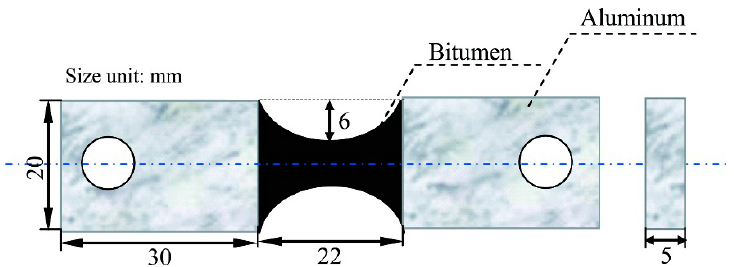
Figure 2. Illustration of tension test sample size. Materials 2016 , 9 , 600